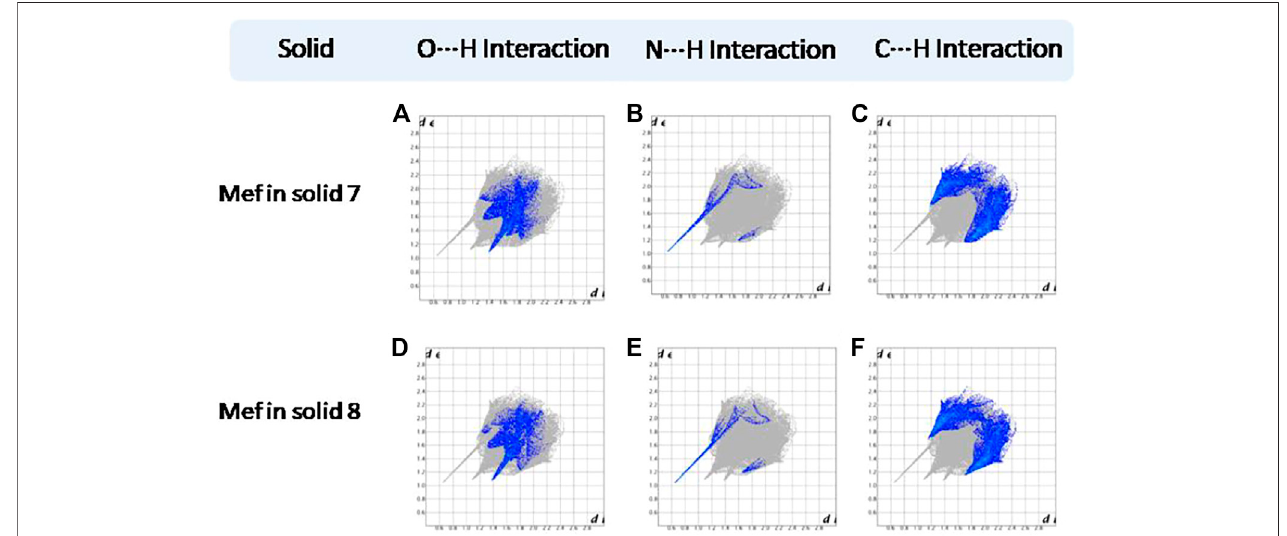
FIGURE 13 | (A – F) Resolved fi ngerprint plots of Mef of 7 and 8 in O ··· H/ H ··· O, N ··· H/H ··· N, and C ··· H/ H ··· C interactions, respectively.